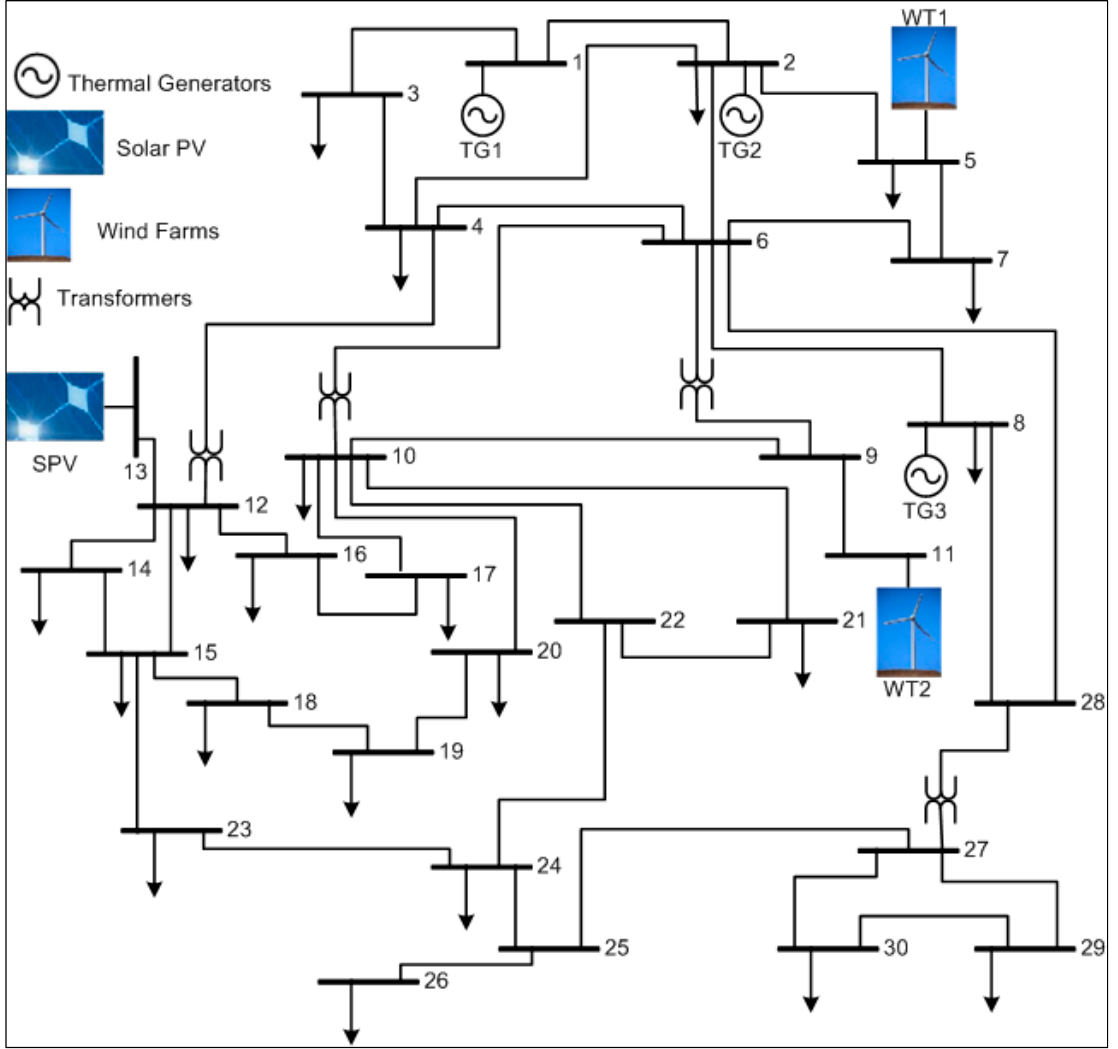
Figure 1. Adapted IEEE 30 bus network with integrated WT and SPV sources. Table 1. Adopted test system details.